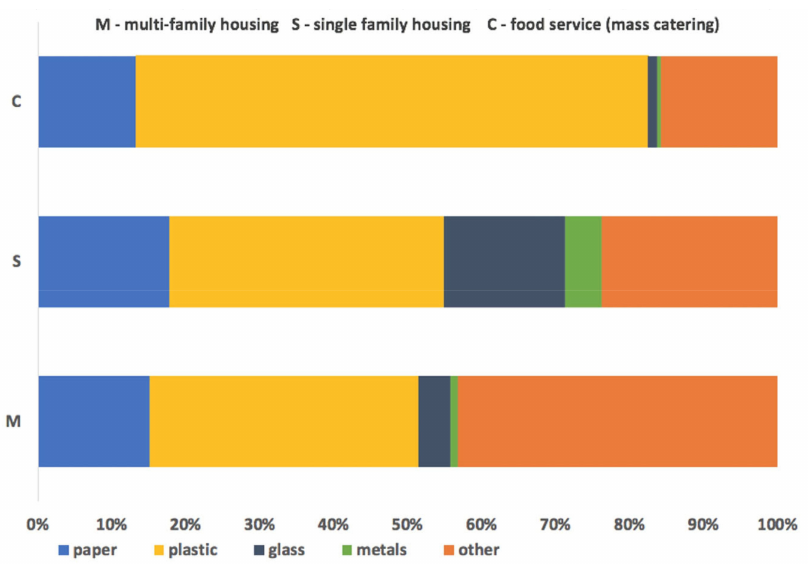
Figure 1. Average composition of impurities in SS-OFMSW from different sources (M, S,